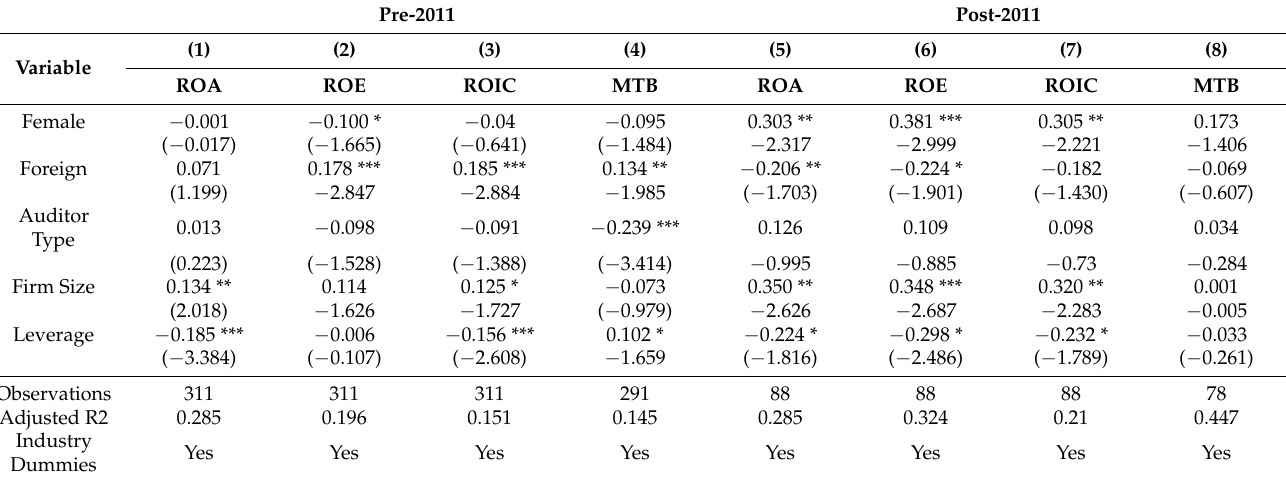
Table 6. Pre- and post-revolution: board